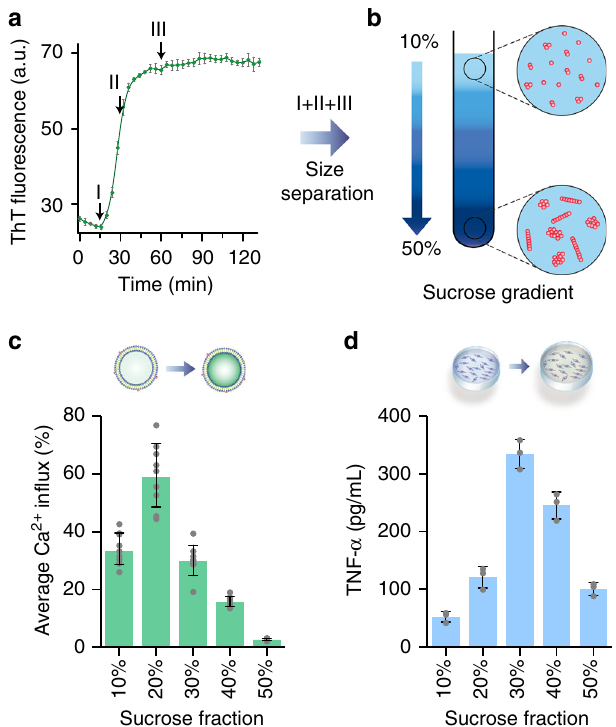
Fig. 2 A β 42 aggregates of diverse sizes exhibit different relative toxicity by distinct mechanisms. a A β 42 aggregation monitored by ThT fl uorescence. Soluble aggregates formed at different time points were mixed together and separated via a discontinuous sucrose gradient. Three different time points during the aggregation of 2 µ M A β 42 in SSPE buffer at 37 °C were chosen: (i) At the end of the lag phase (15 min), (ii) at the middle of growth phase (30 min) and (iii) during the plateau phase (60 min). b Aliquots collected at these time points were loaded in a step gradient of 10% to 50% sucrose and ultracentrifuged and the fractions were collected immediately and stored. The sizes of the aggregates present within different densities of the sucrose solution increase with the sucrose density. c The lipid bilayer permeability assay shows that aggregates present at 20% sucrose are the most potent at membrane permeation. d Aggregates presents at 30% sucrose are the most effective at inducing in fl ammation. These experiments were carried out for two independent aggregation reactions of A β 42 ( n = 2) and the error bars represent the standard deviation of the mean for each fi eld of view (for 2C) and for each well (2D). Source data of a , c and d are provided as a Source Data fi